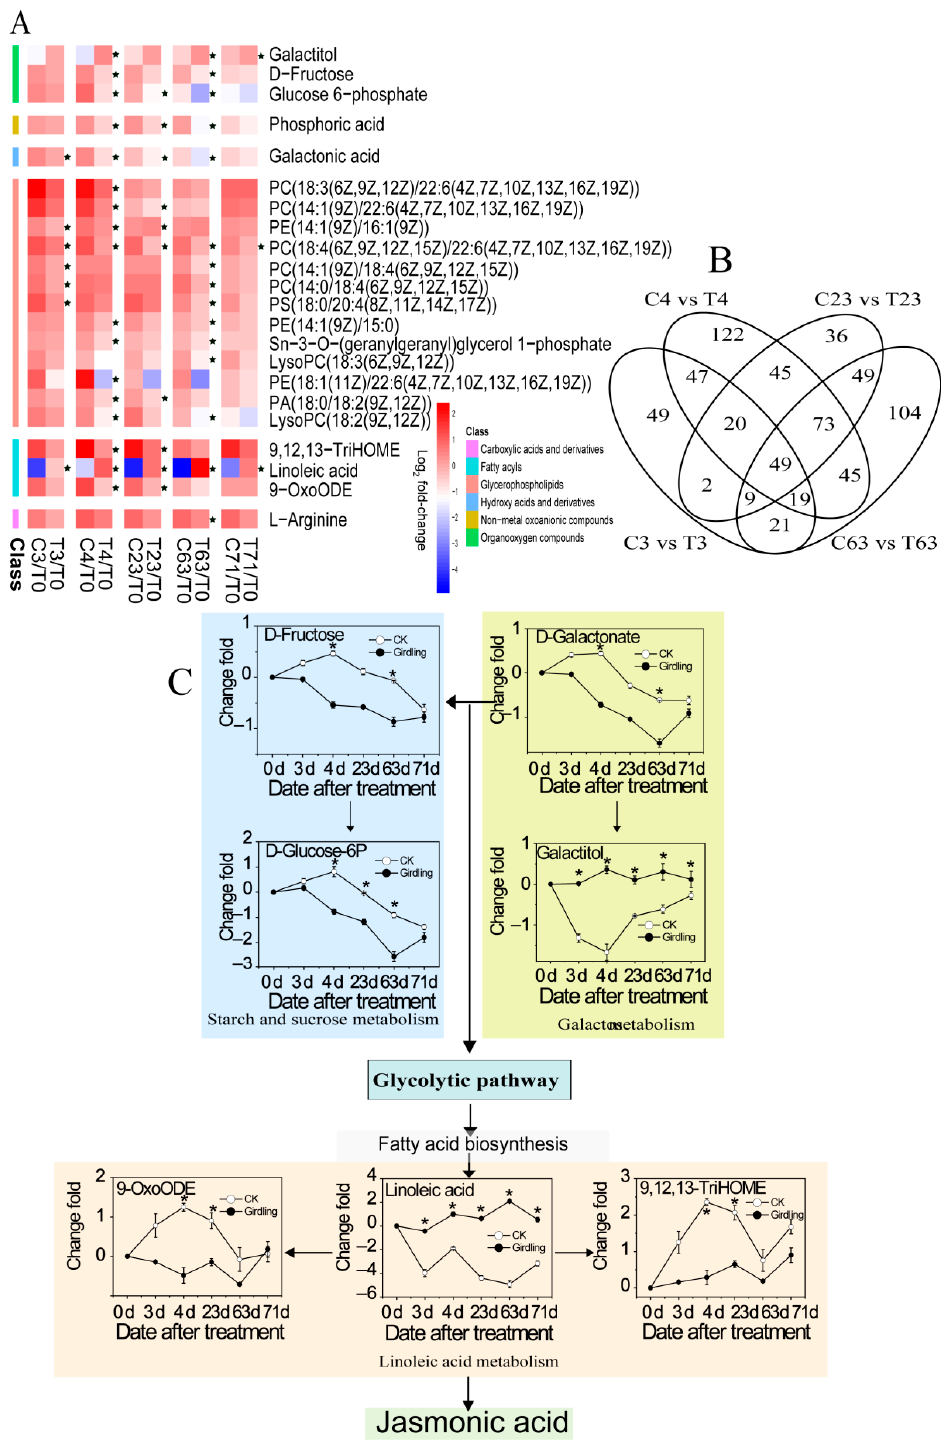
Figure 7. Metabolites accounting for flowering rate in Guiwei litchi leaves from terminal flushes at turning stage were screened. ( A ): Heat map of fold-changes relative to 0 day for metabolites accounting for flowering rate in Guiwei litchi leaves from terminal flushes. C indicates samples of trees from the control group. T indicates samples of trees from the girdled group. The numbers 0, 3, 4, 23, 63, and 71 indicate the sampling time. Values represent the means of log2-transformed fold-changes from six biological replicates relative to the T0 (before treatment). Asterisks (*) indi-